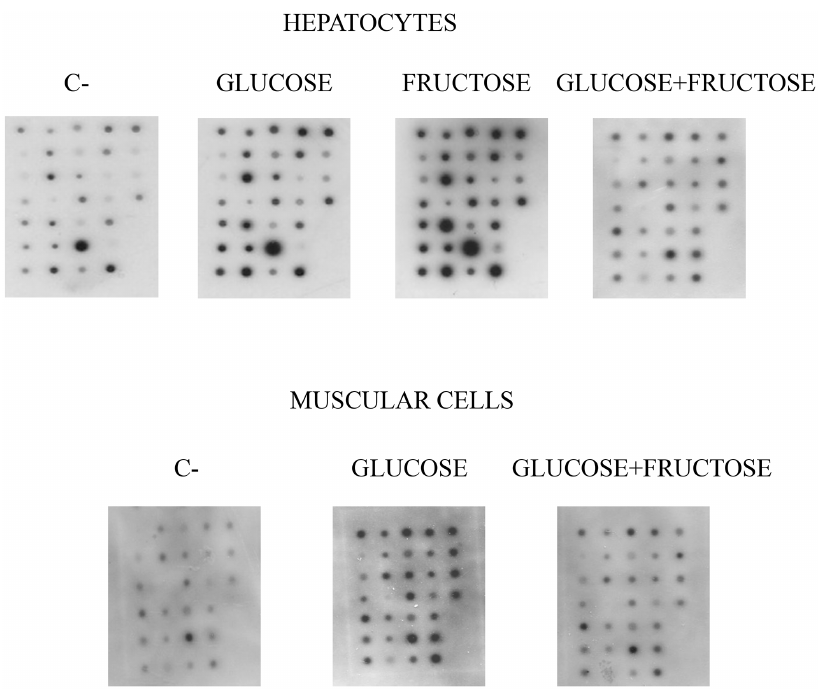
Figure 3. Mini-array analysis of the serine phosphorylation status of several proteins involved in overall cell function and the regulation of cell cycle in isolated hepatocytes and cultured skeletal muscle cells after incubation with a range of concentrations of glucose, fructose or glucose plus fructose. The mini-array analysis and the distribution of the proteins are described in the Material and Methods section and Figure 1. Isolated hepatocytes and skeletal muscle cell cultures were obtained and incubated as described in the Material and Methods section. The serine-phosphorylation levels of each spot in the mini-arrays were then analyzed. Control: cells incubated for 5 min without the presence of any monosaccharide. Glucose: cells incubated for 5 min in the presence of 10 mM glucose. Fructose: hepatocytes incubated for 5 min in the presence of 10 mM fructose. Glucose + Fructose: cells incubated for 5 min in the presence of 10 mM glucose plus 75 m M fructose. Hepatocytes: isolated hepatocytes. Muscle: skeletal muscle cell cultures. The figures shows a representative image for five separate